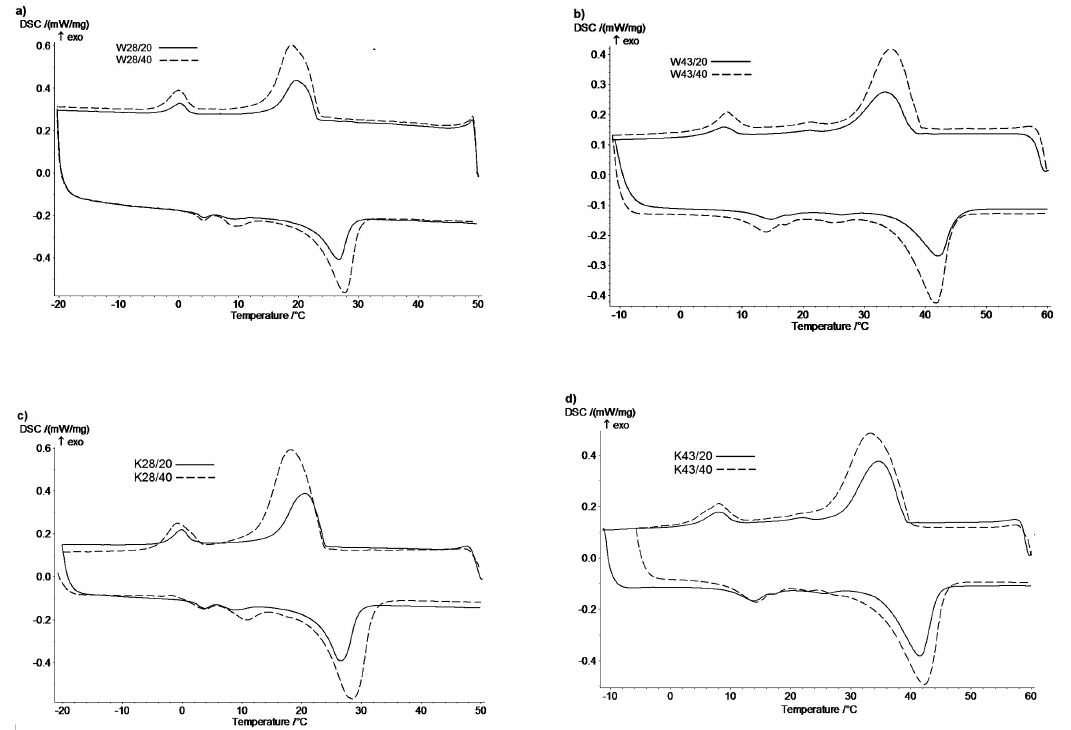
Figure 2. DSC thermograms of woven fabrics with ( a ) MPCM28, ( b ) MPCM43 and knitted fabrics with ( c ) MPCM28, ( d ) MPCM43.